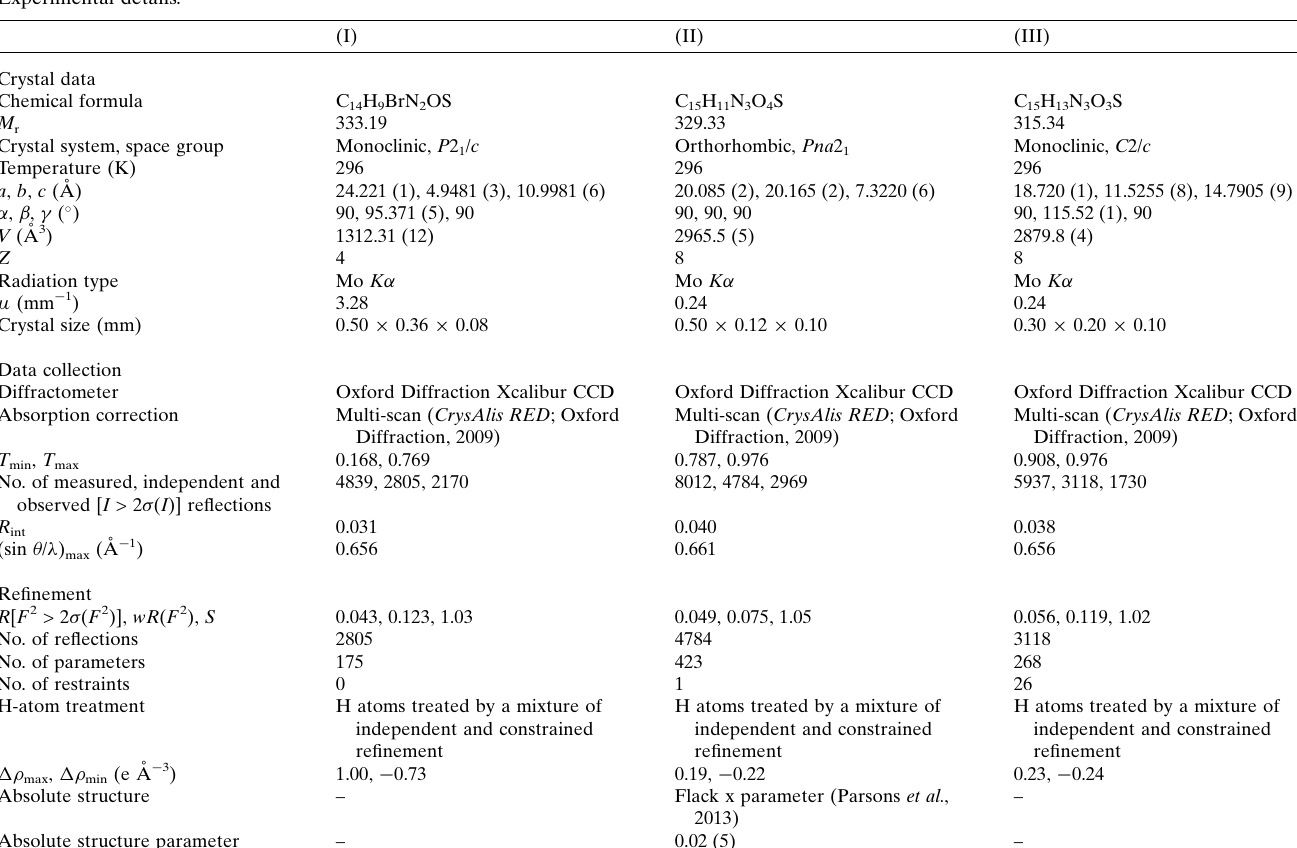
Table 2 Experimental details.